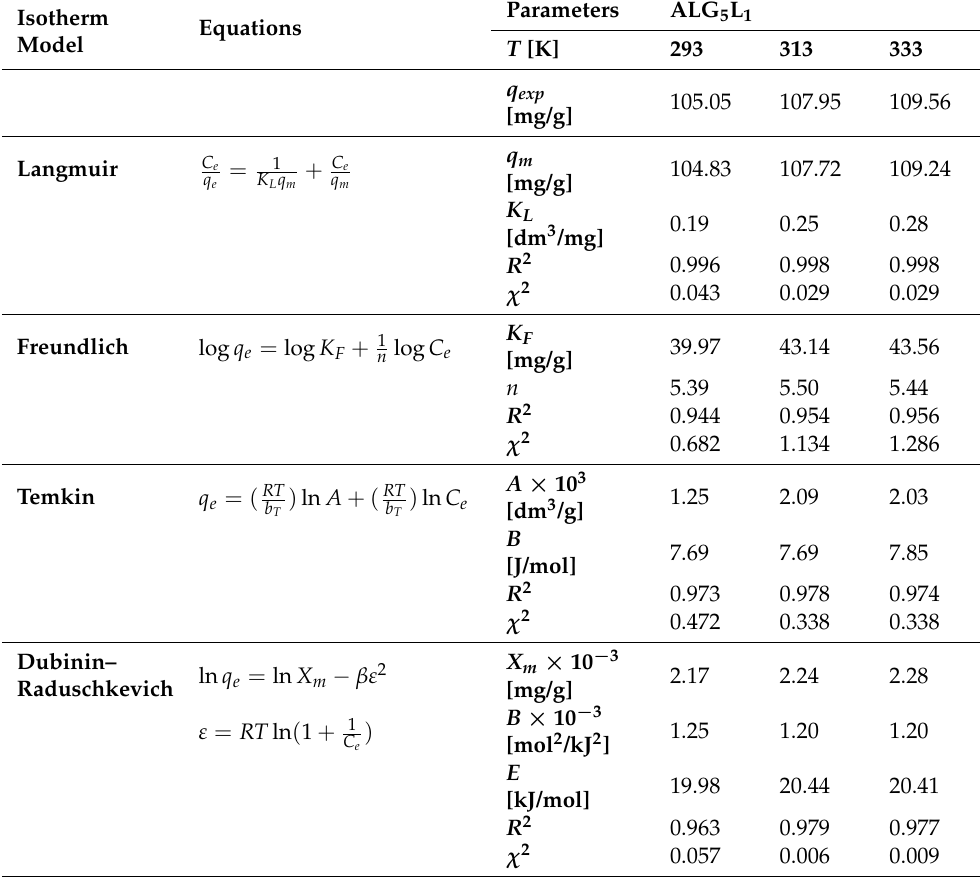
Table 2. Calculated isotherm parameters for the La(III) ions sorption onto the ALG 5 L 1 composite b . Isotherm Model